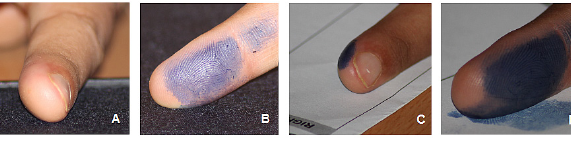
Figure 1. Method for obtaining fingerprints. A and B show the rolling of the finger from the radial side to ulnar side on an ink pad. C and D show the transference of fingerprints onto the allocated area of the